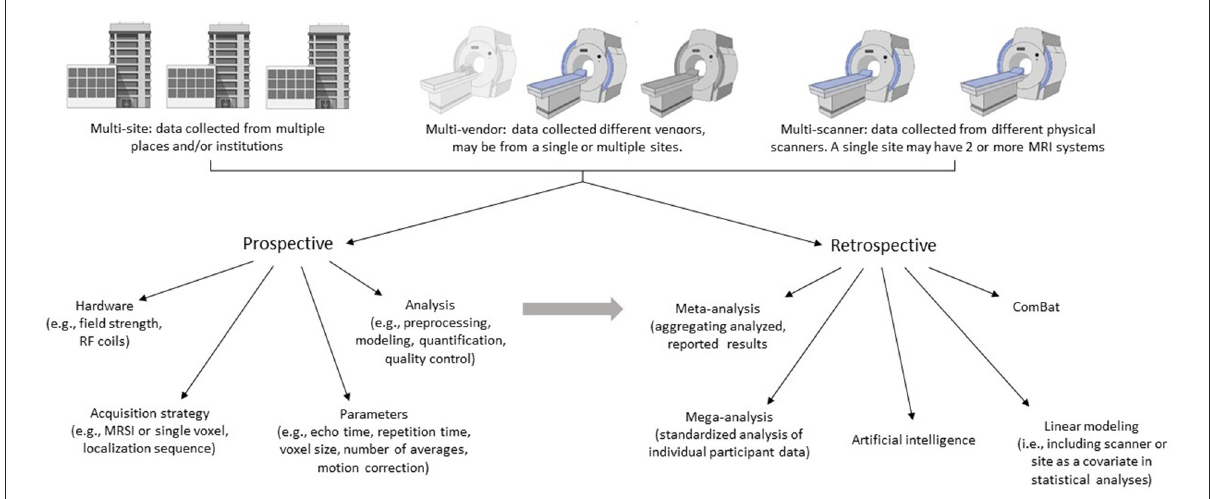
FIGURE1 Aggregating multi-site, multi-vendor, or multi-scanner MRS data is an efficient way to increase sample sizes. Here we outline two approaches for data aggregation: Prospective and retrospective. Each may be appropriate in different scenarios depending on the research question and resources. The challenge and goal of aggregating data is to achieve balance between data consistency, data quality and data quantity. Prospective study designs should consider the technical factors and analysis pipelines that will impact metabolite quantification. Retrospective study designs aggregate previously collected data and therefore have little control over data acquisition parameters, instead focusing on analysis and harmonization strategies. The strategies applied in retrospective designs may also be applied to prospectively acquired data. Created with